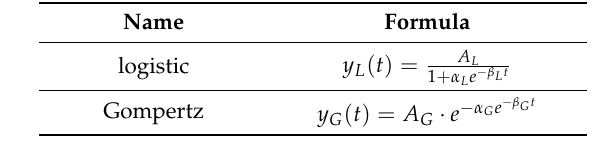
Table 1. The S-curve formulas of logistic and